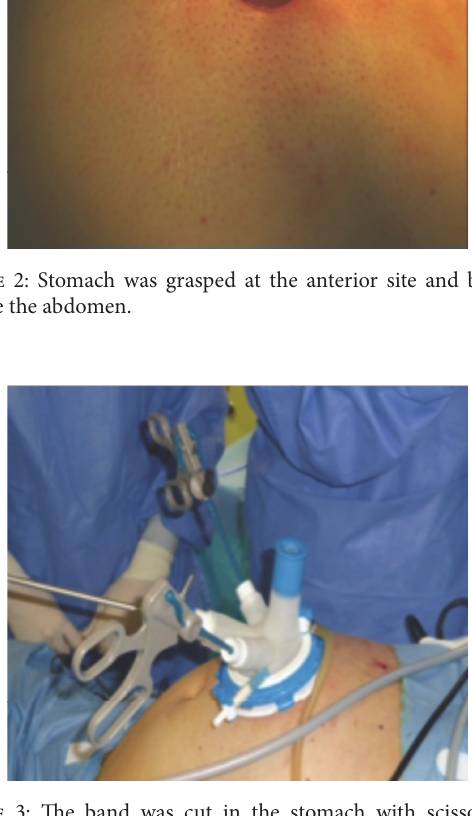
Figure 3: The band was cut in the stomach with scissors and